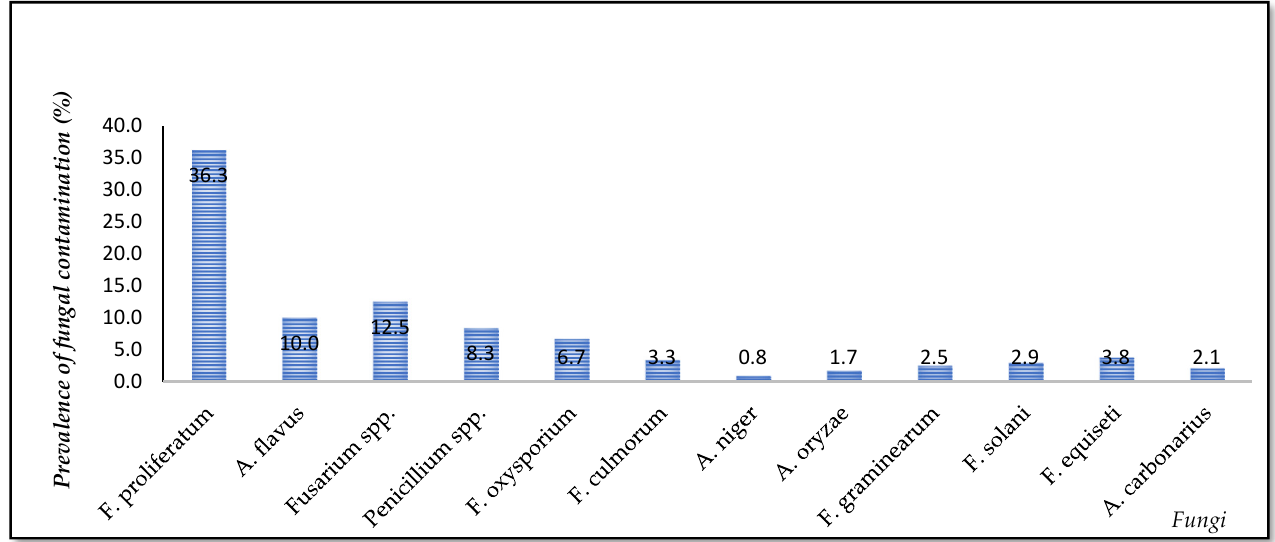
Figure 3. Prevalence of samples contaminated by fungi in the Vietnamese rice chain (based on characterization of isolates).